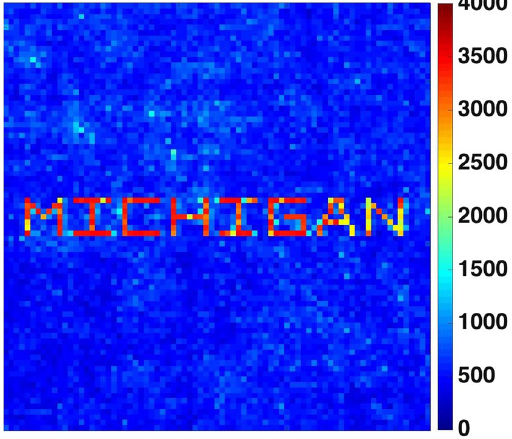
Figure 7. With M = 100 and a ground glass as a scattering medium, we compute the optimal focusing wavefront for values of k l ( , ) that spell out “MICHIGAN”. Here we plot the maximum intensity of transmitted fields for all k l ( , ) . See https://vimeo.com/194525444 for an etch-a-sketch type video of the